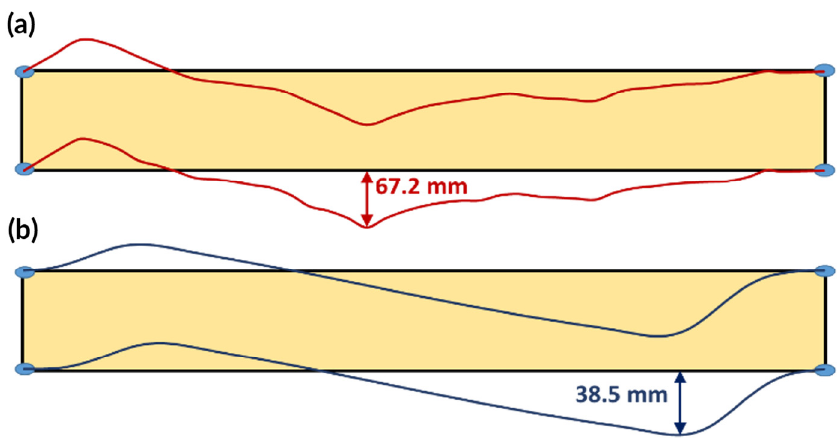
Figure 8. Horizontal displacement of the arch axis in the assumed global geometric imperfection used in FEM analyses: ( a ) the real geometric imperfection based on the data obtained from the 3D laser scanning; ( b ) the theoretical geometric imperfection in the form of the first buckling mode with the amplitude scaled on the basis of allowed tolerances.